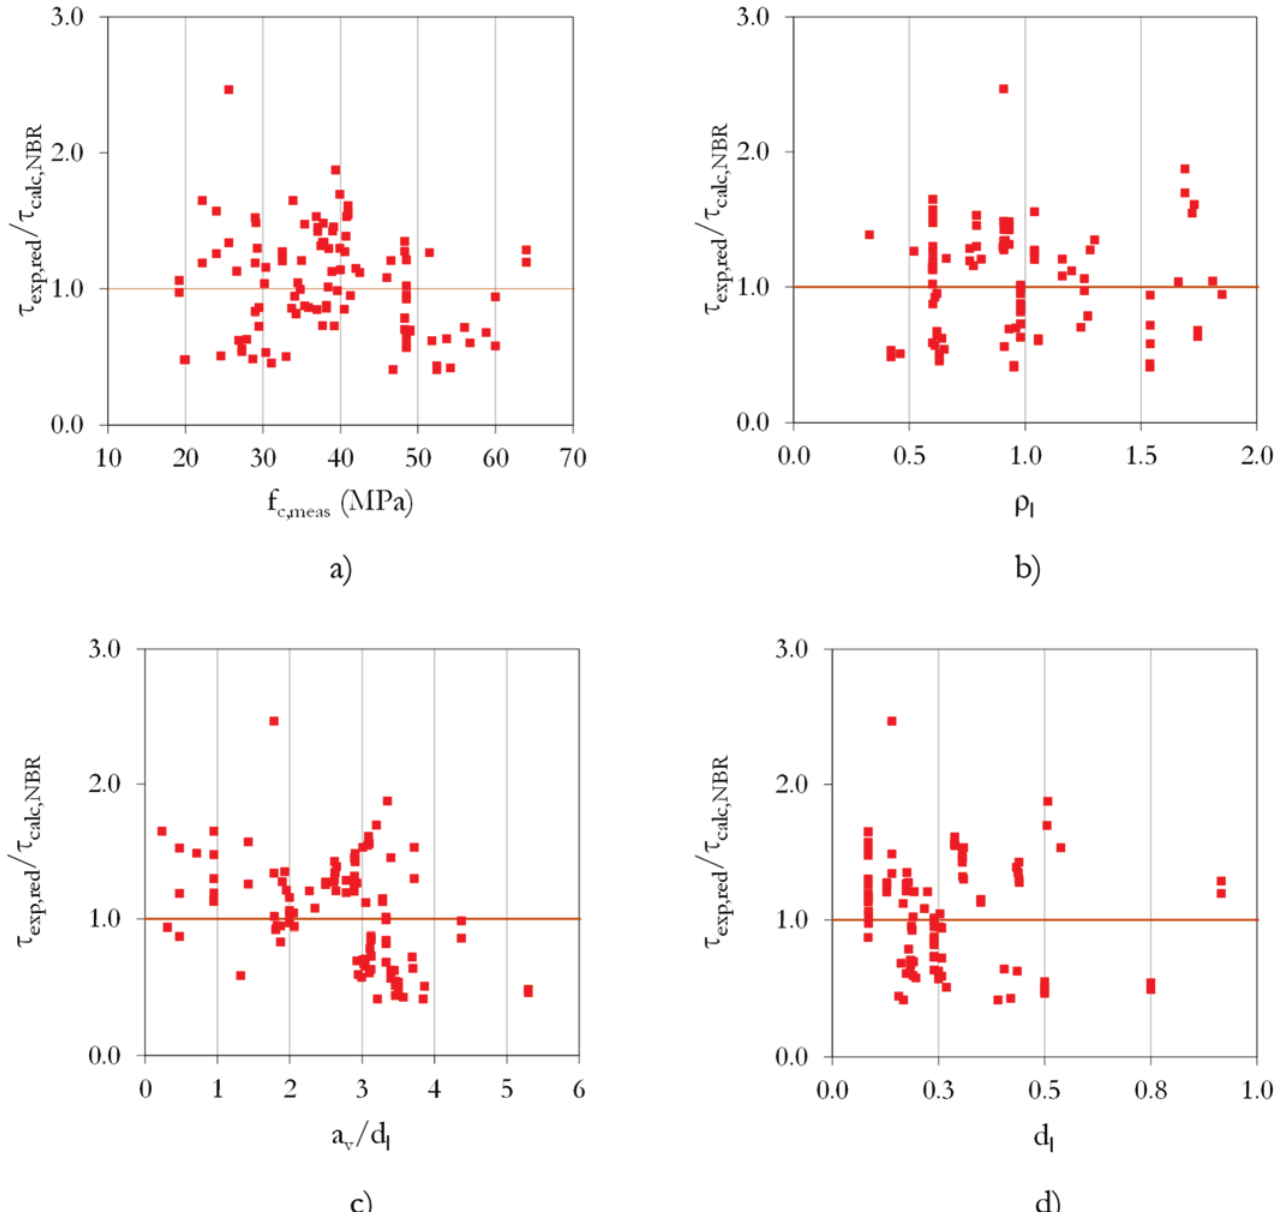
τ / τ ratio ( γ = 1) according to ABNT NBR 6118:2014 with: a) compressive strength of concrete f exp calc,NBR c b) Ratio of flexural reinforcement ρ